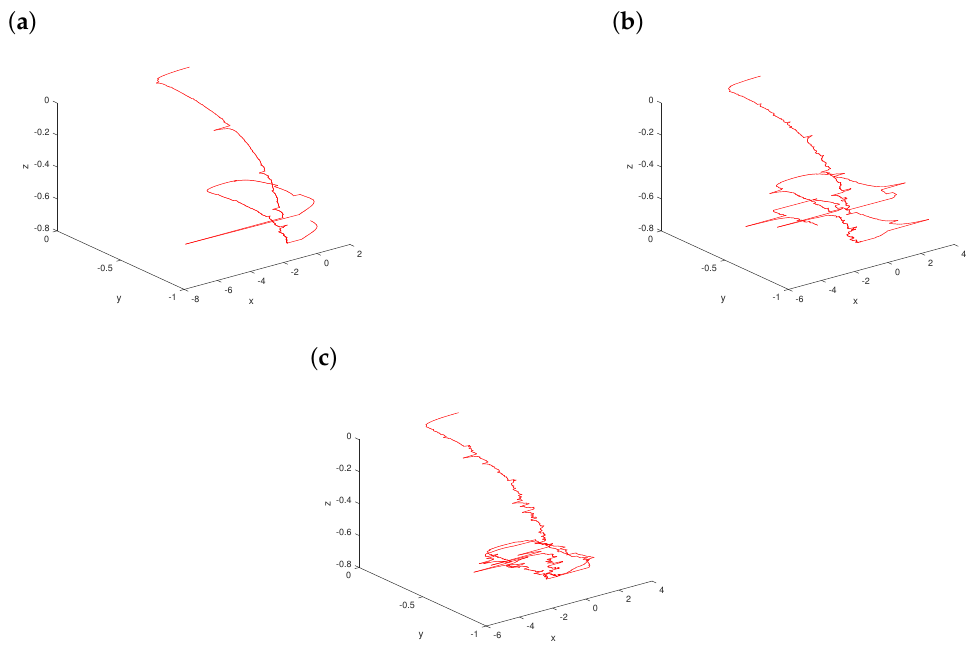
Figure 6. The evolution of system (11) for one set of initial conditions x ( 0 ) = y ( 0 ) = z ( 0 ) = 0 with a fixed stability index α = 1 and a scaling parameter (cid:101) = 0.1 as the noise intensity increases: ( a ) σ = 0.1; ( b ) σ = 0.5; ( c ) σ =